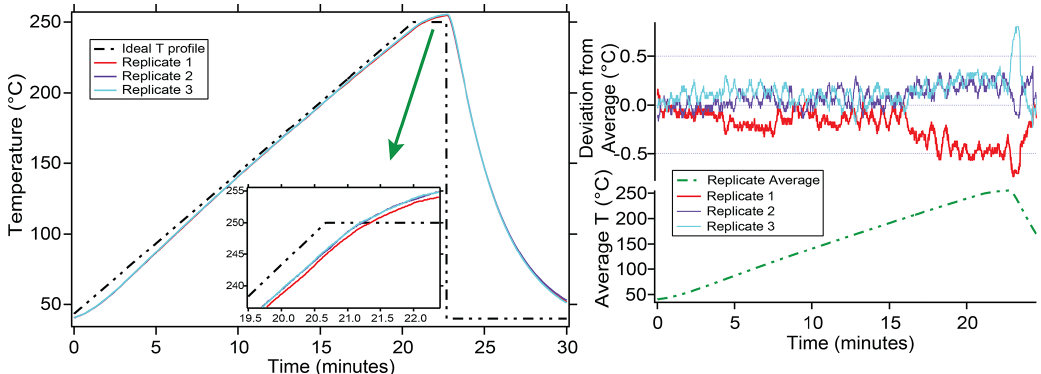
Figure A2. Demonstration of reproducibility of temperature ramps on the miniature gas chromatographs. This leads to consistent elution times of compounds of interest, streamlining batch peak